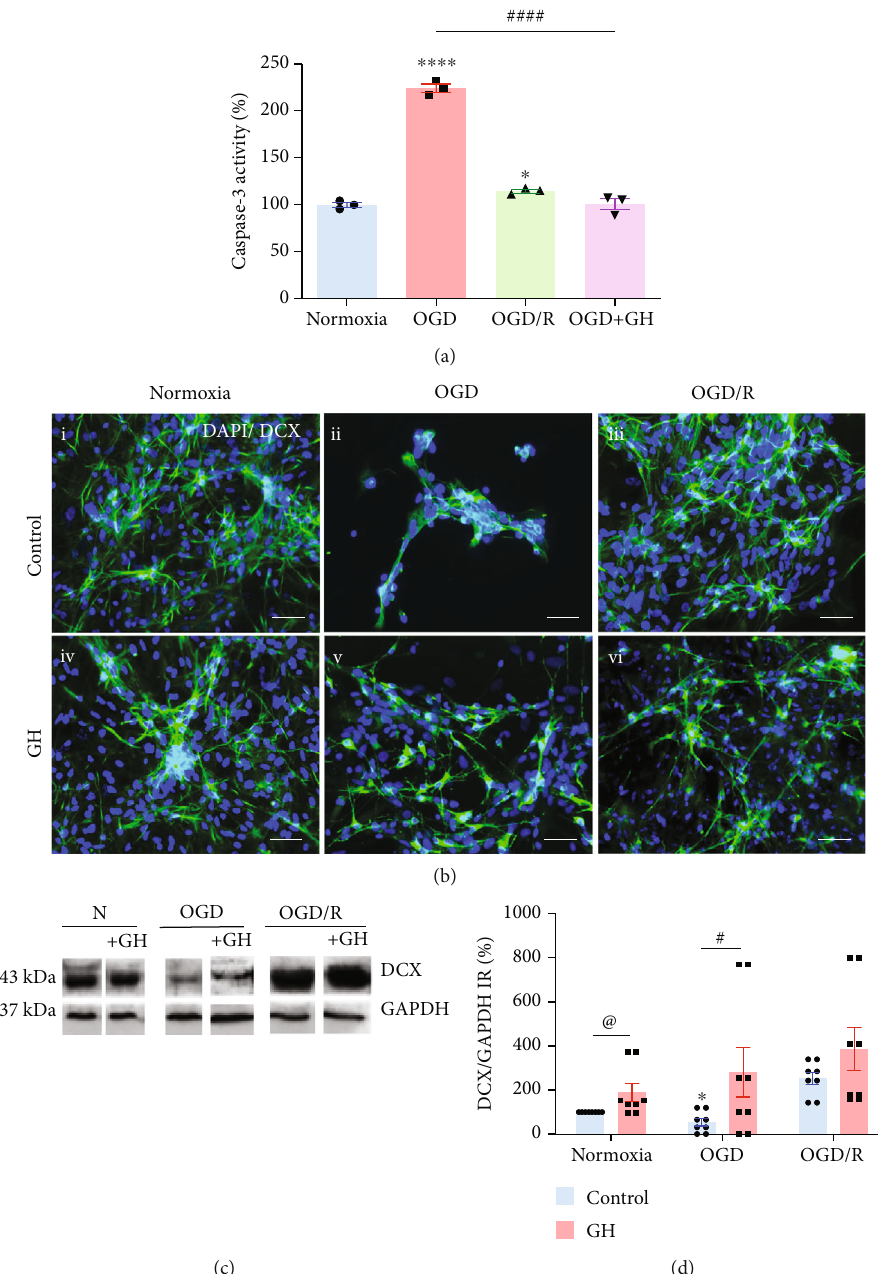
Figure 6: E ff ect of growth hormone (GH) upon apoptosis and doublecortin-immunoreactivity (DCX-IR) in hippocampal cultures exposed to OGD and reoxygenation (OGD/R) conditions. (a) Caspase-3 activity as determined with a colorimetric assay. Bars represent mean ± SEM . Asterisks ( ∗ ) indicate signi fi cant di ff erences in comparison to control ( ∗ p < 0 : 05 ; ∗∗∗∗ p < 0 : 0001 ), and number sign (#) shows di ff erences between experimental groups (#### p < 0 : 0001 ) as assessed by one-way ANOVA and Tukey as posthoc test. (b) Representative immuno fl uorescence merged images from each experimental group: (i) normoxia, (ii) OGD, (iii) OGD/R, (iv) normoxia + GH, (v) OGD + GH, and (vi) OGD/R + GH. Cell nuclei were stained with DAPI (blue) and neurons with anti-DCX (green). Scale bar: 50 μ m. (c) Representative Western blots for DCX-IR. (d) Densitometric analysis of immunoblots for DCX-IR (corrected and normalized with GAPDH immunoreactivity). Bars represent mean ± SEM . Asterisks ( ∗ ) indicate signi fi cant di ff erences in comparison to control ( ∗ p < 0 : 05 ), and number sign (#) shows di ff erences between experimental groups (# p < 0 : 05 ) as assessed by two-way ANOVA and Tukey as posthoc test. An unpaired Student ’ s t -test was used to compare control versus GH in Nx condition (d), and the at sign (@) indicates a signi fi cant di ff erence (@ p < 0 : 05